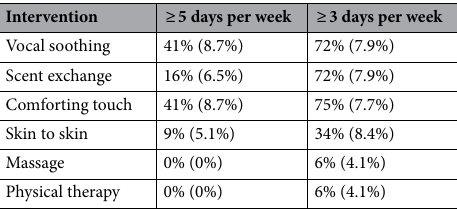
Table 3. Per patient